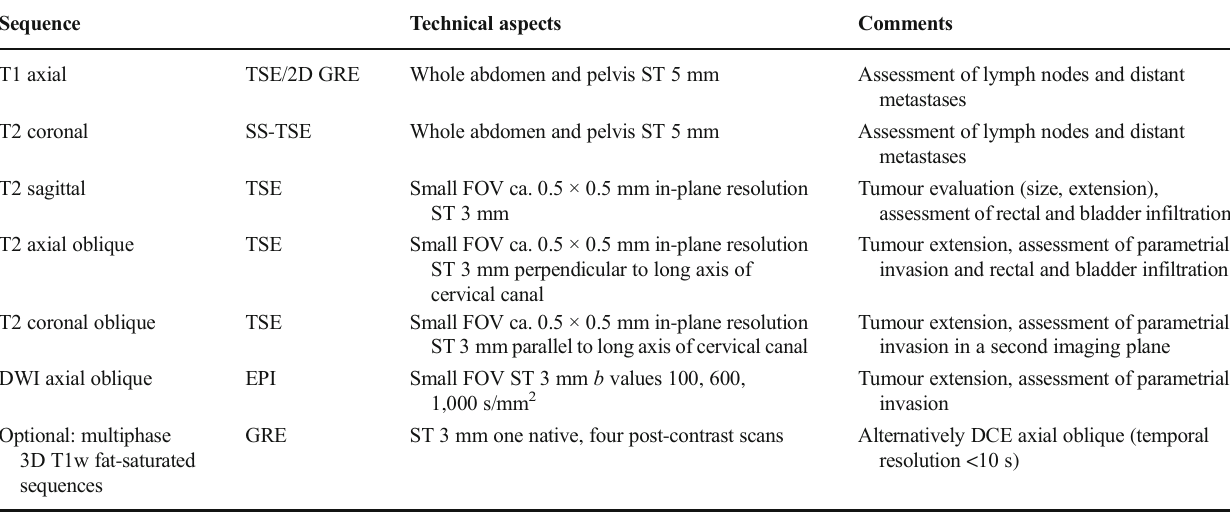
Proposed MRI protocol for cervical cancer staging Sequence Technical aspects